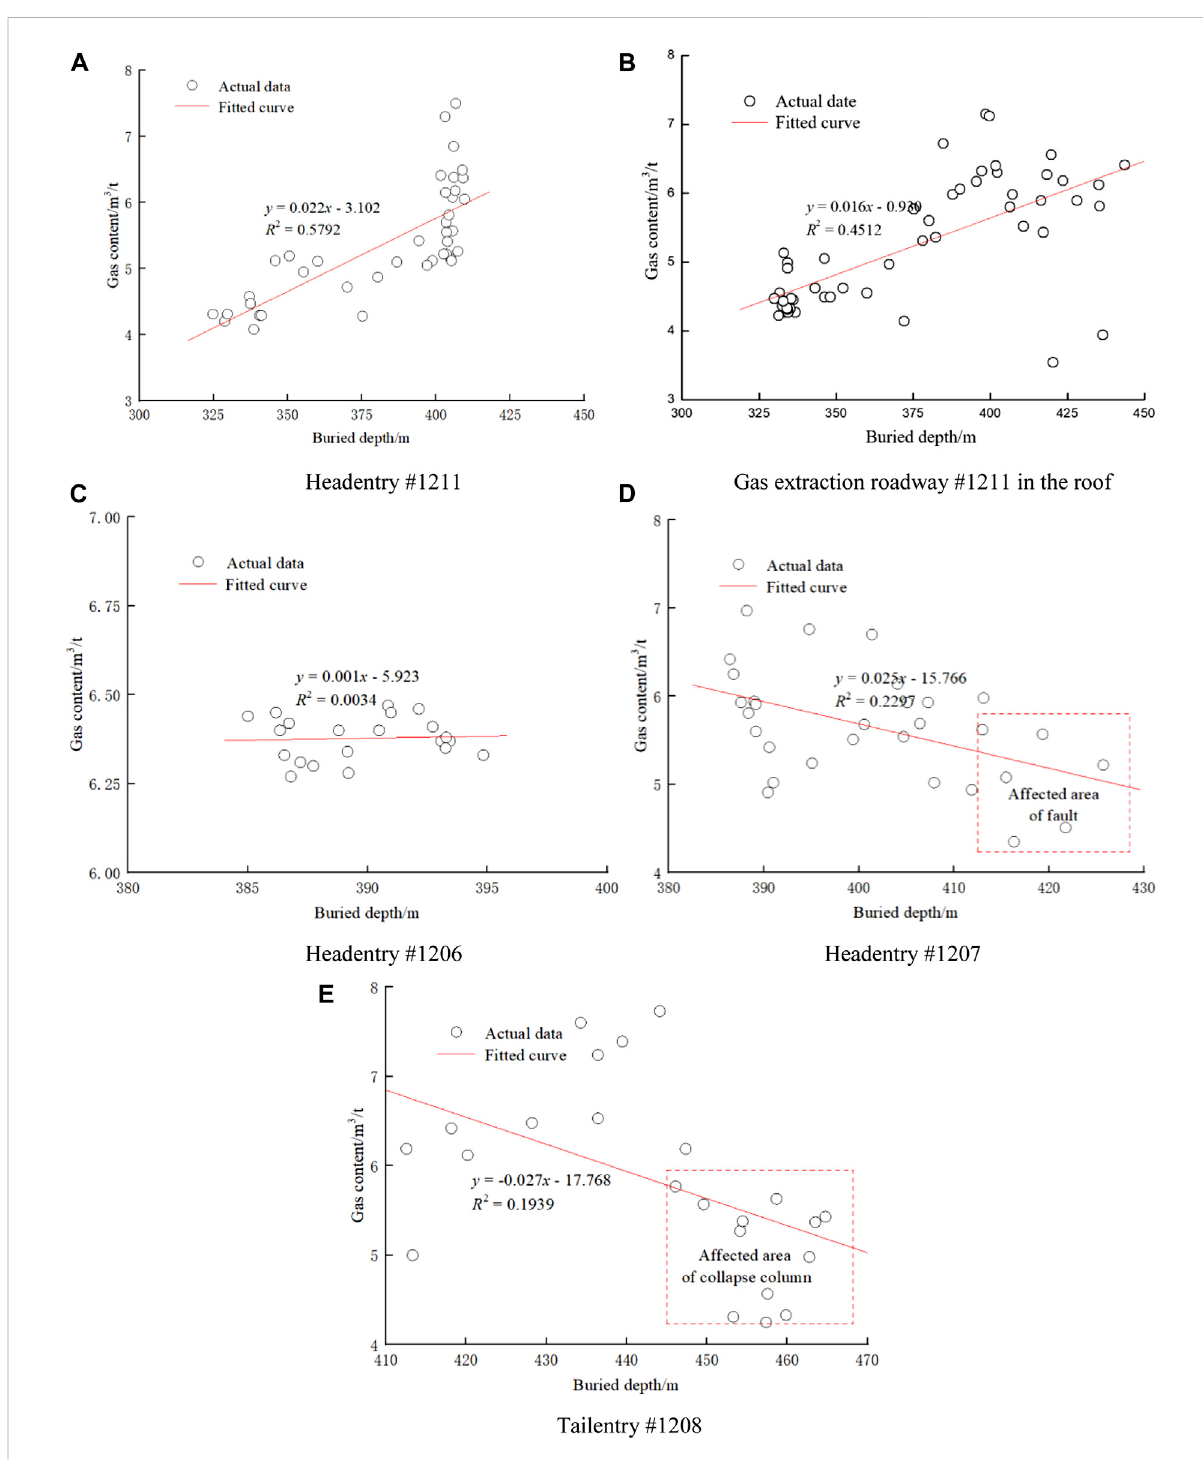
FIGURE 3 Gas content scatter with fi tting curve with the increased buried depth at each panel in district